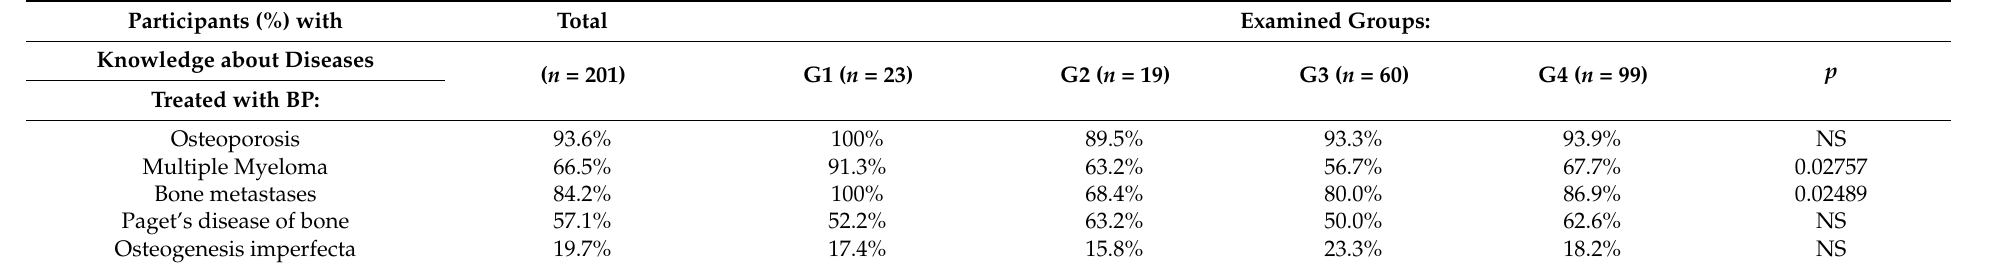
Table 2. Answers to the question concerning the diseases treated with